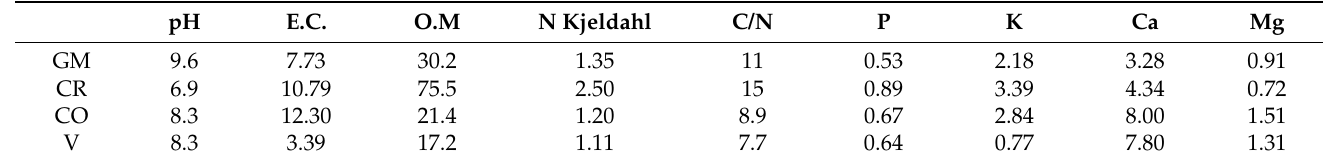
Table 2. Physiochemical proprieties of materials used as amendment: GM (goat manure); CR (crop residues); CO (compost); V